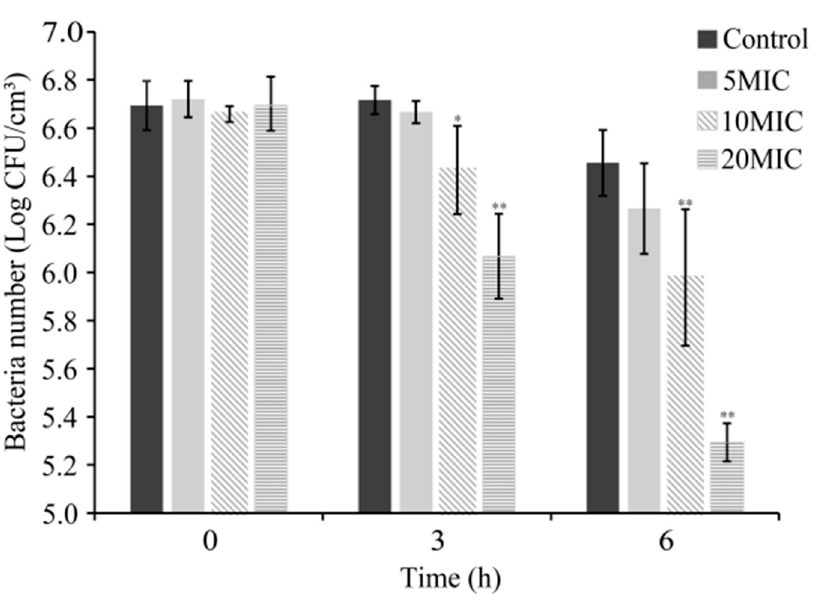
Figure 3. Antimicrobial effect of CoQ 0 on inoculated S. Typhimurium on raw chicken. Bars represent the standard deviation ( n = 3). Control represents no CoQ 0 added. * p < 0.5 compared with the control, ** p < 0.01 compared with the control.